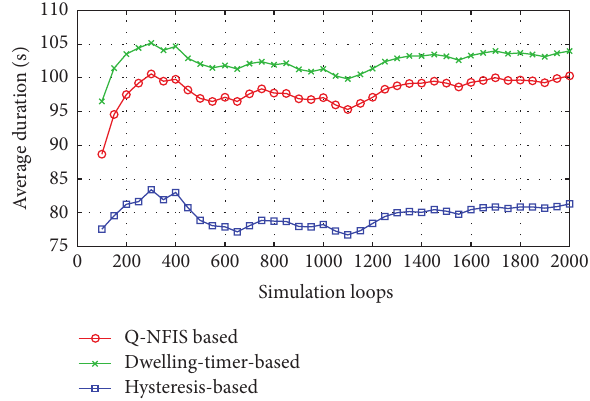
Figure 7: Comparison of average duration for 3 algorithms in 2000 simulation